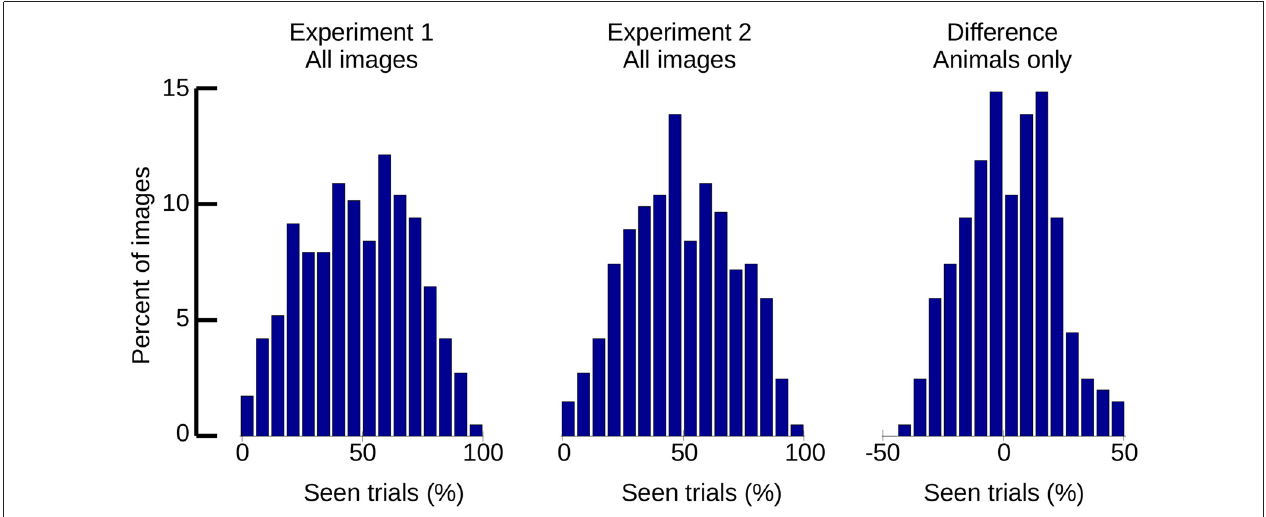
FIGURE 11 | Histograms of “seen” trials, per image. Left: all stimuli of Experiment 1. Middle: all stimuli of Experiment 2. Right: difference between Experiments 1 and 2 (animal stimuli only).